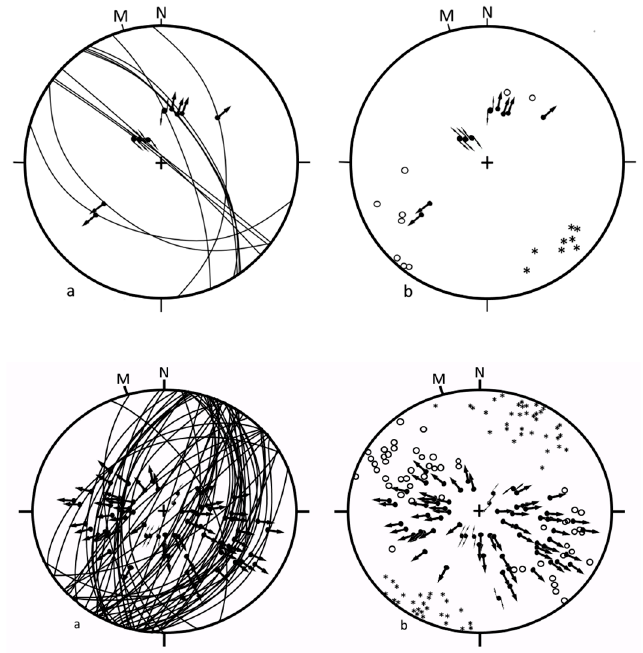
Figure 4. Regime 2 ( top ) and Regime 3 ( bottom ). Lower Hemisphere Equal Area projection of ( a ) great circles of fault planes; and ( b ) poles to fault planes (open circles) and of calculated trend and plunge (*) of σ 2 . Symbols are as in Figure 3.